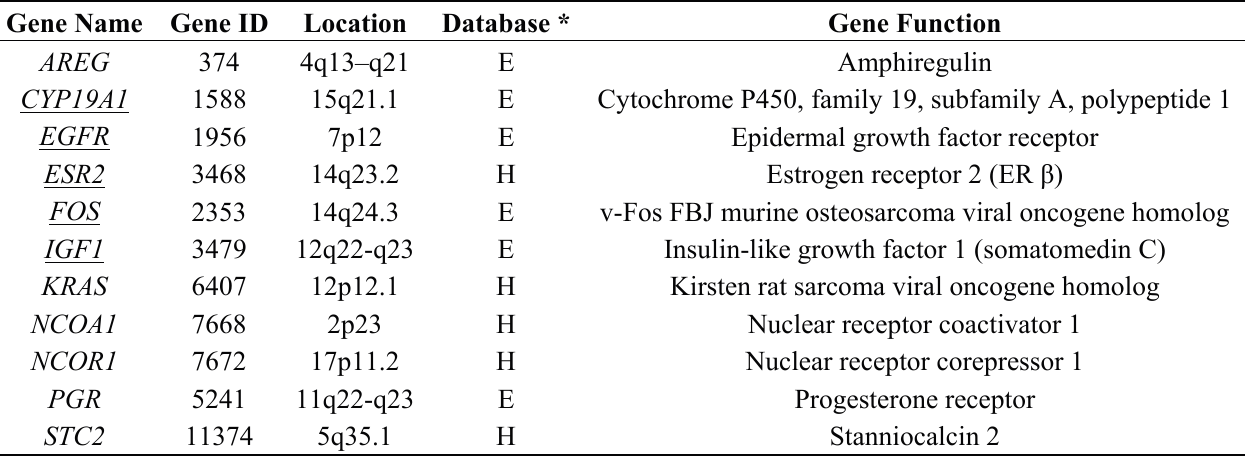
Table 8. Integration of changes in the expression of genes showing common genes modified in EDCs, breast cancer and endometriosis. The underlined gene names show a total of five genes that were common among all three EDCs (PCBs, phthalate and bisphenol A), breast cancer, and endometriosis. Environmentally responsive genes are indicated in database